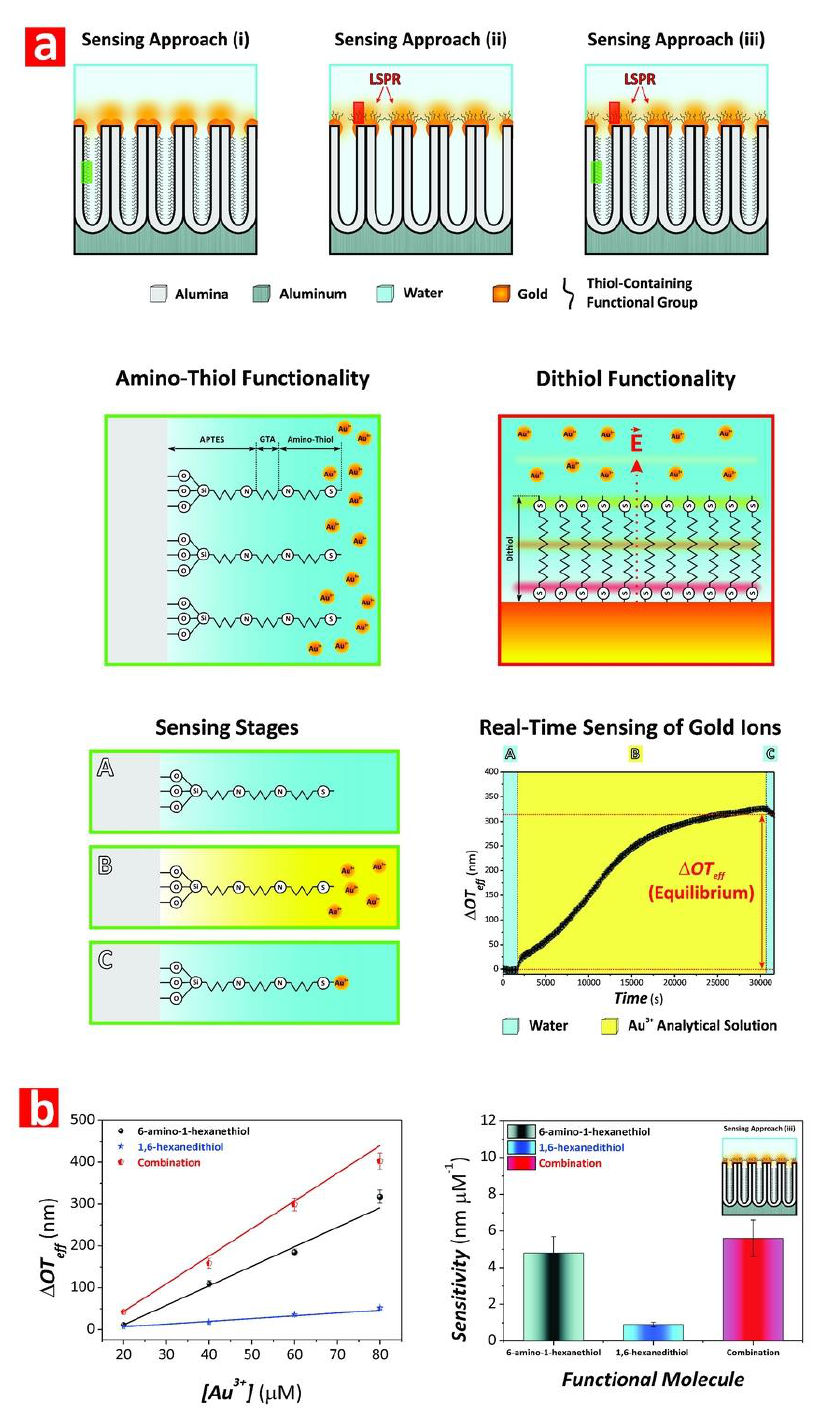
the PSB red-shifts whereas the transmission intensity is reduced. red-shifts whereas the transmission intensity is reduced.